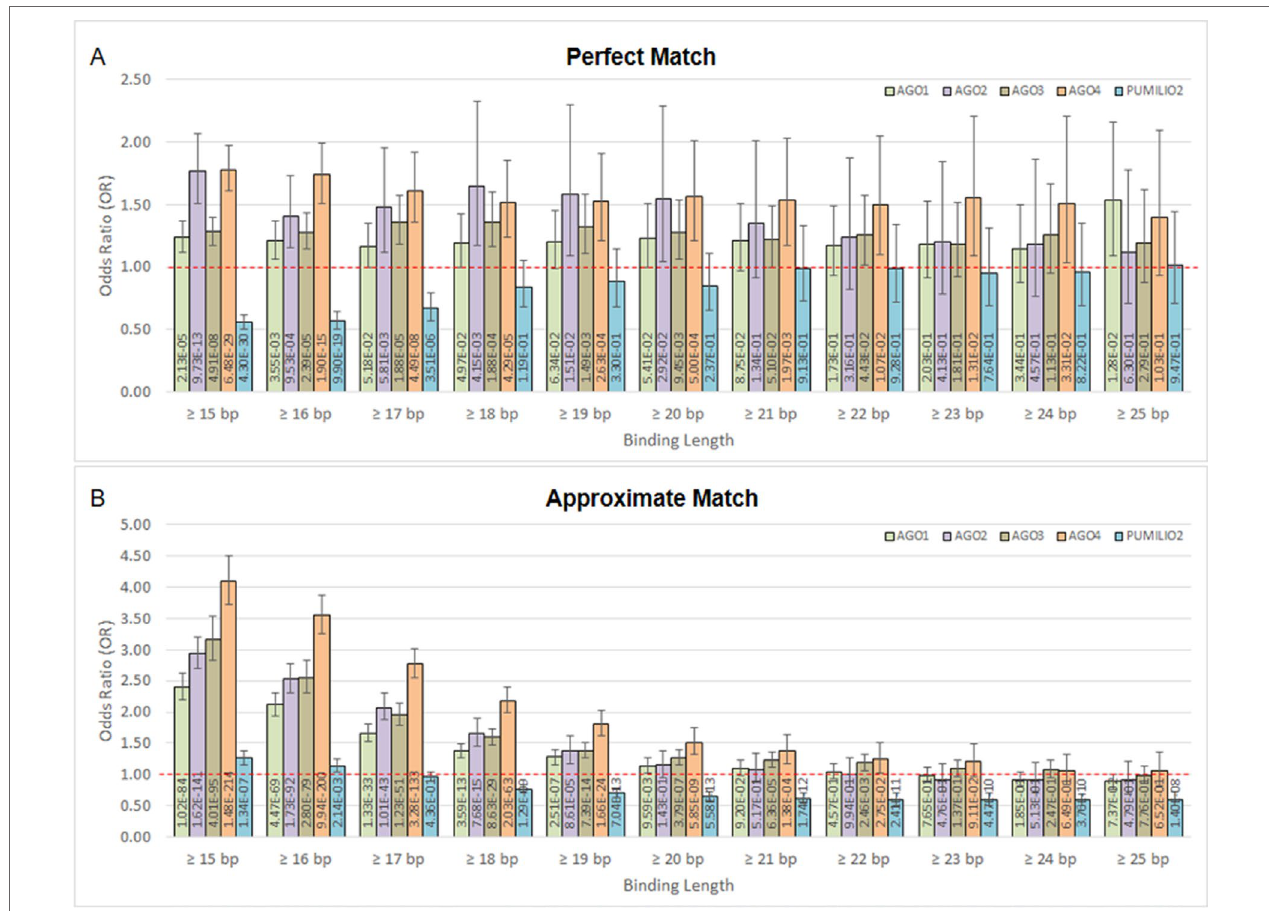
FIGURE 2 | The association between methylation levels and protein-binding sites. The Chi-square p -values are calculated from 2 × 2 contingency tables that count the number of methylation probes. The rows of a contingency table separate highly and lowly methylated probes, whereas the columns separate probes that are in proximity with protein-binding sites and probes that are not. Note that a single probe might be in proximity with multiple protein. (A) Only ChIP DNAs that are perfectly matched with the human genome are included. (B) Only ChIP DNAs that are approximately matched with the human genome are included. This also includes perfectly matched